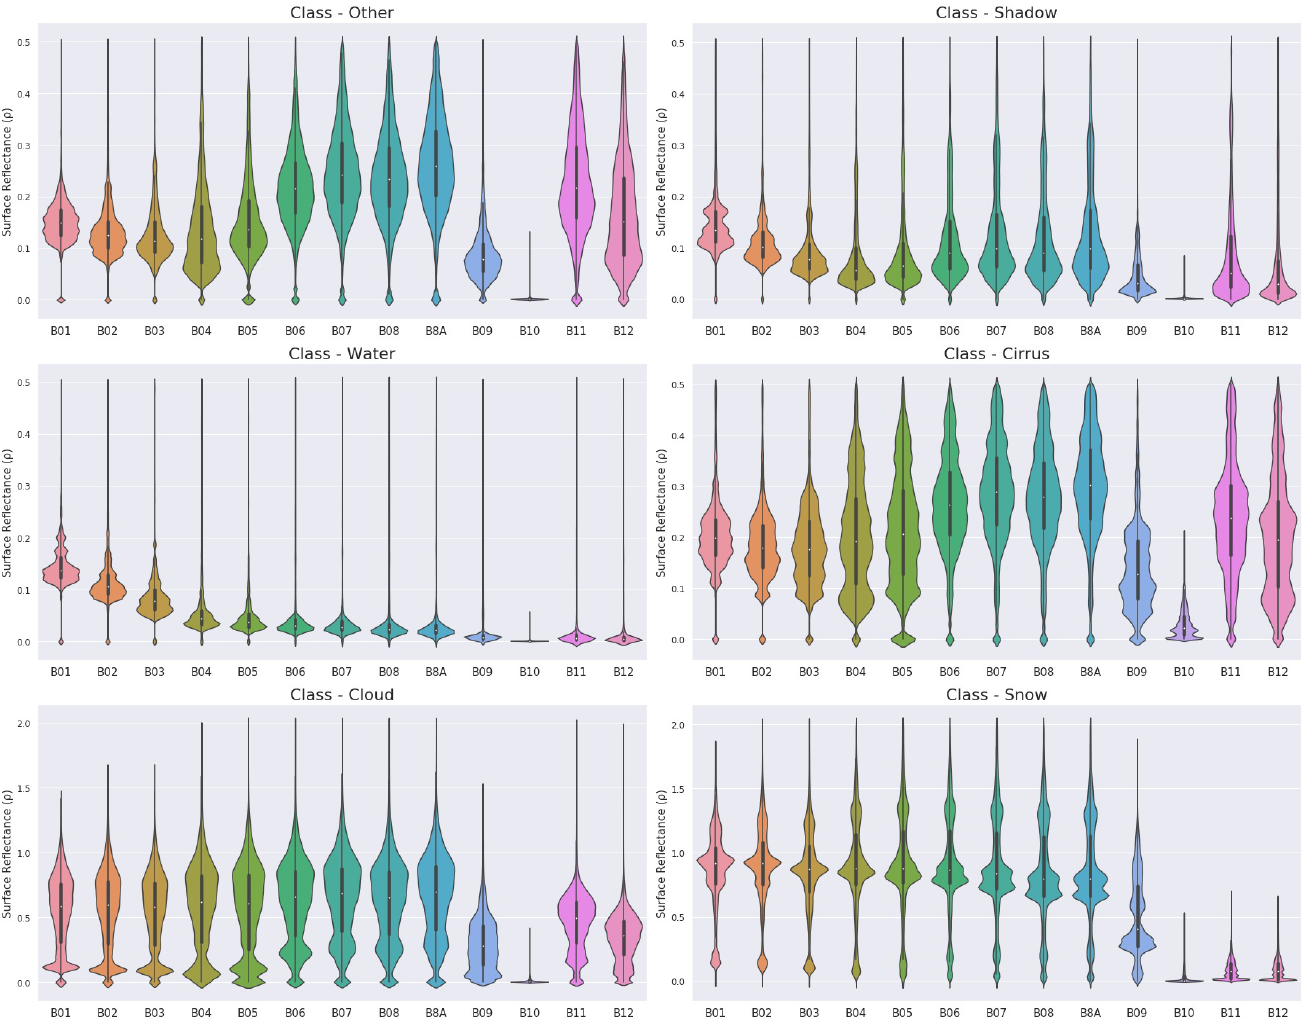
Figure 4. Extended Dataset: Class-wise Surface Reflectance ( ρ ) Value Distribution over 13 Bands. Table 3. Extended Dataset: Point Distribution Overview of Band/Class wise Surface Reflectance ( ρ ) Greater than 1.0.